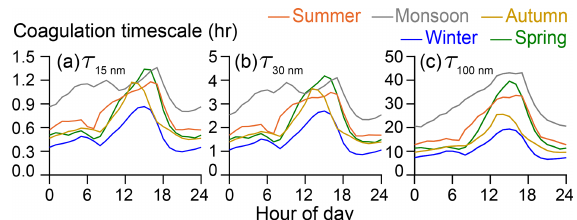
Figure 8. Coagulation timescale ( τ ) for 15, 30, and 100nm particles by